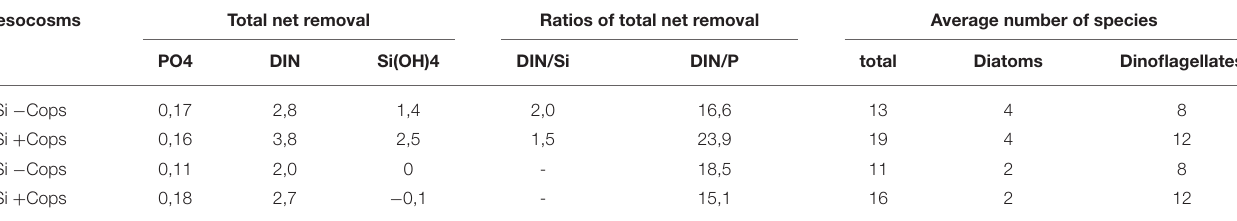
TABLE 1 | Total net nutrient removal during the experiment, ratios between removal, and average number of species during the duration of the experiment. Mesocosms Total net